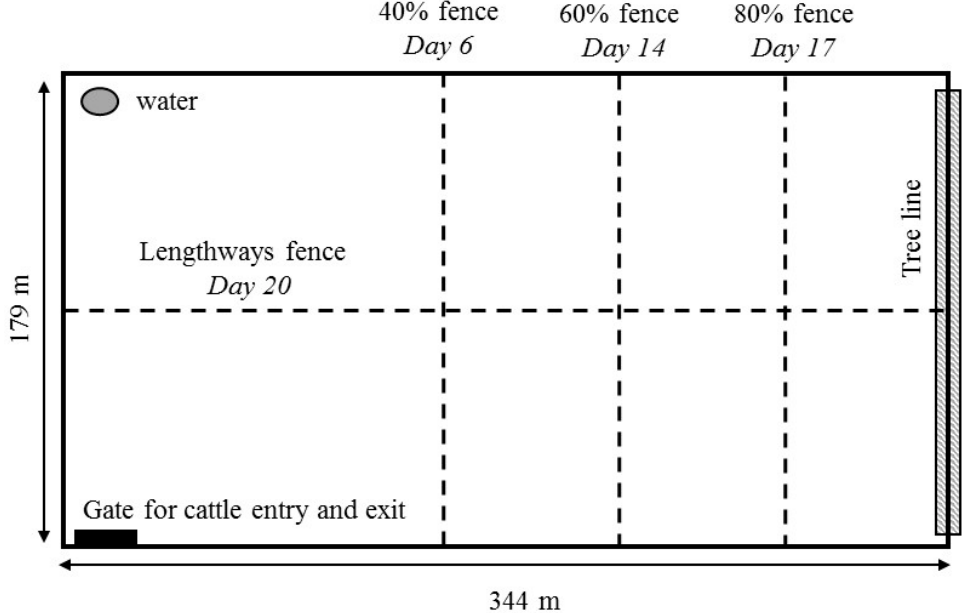
Figure 1. The test paddock for the virtual fencing trial showing the position of the water trough, the tree line overhanging the upper physical fence boundary, and the gate for cattle entry into and exit from the paddock. The dashed lines represent the virtual fence boundaries that were sequentially implemented in the paddock over the trial duration.